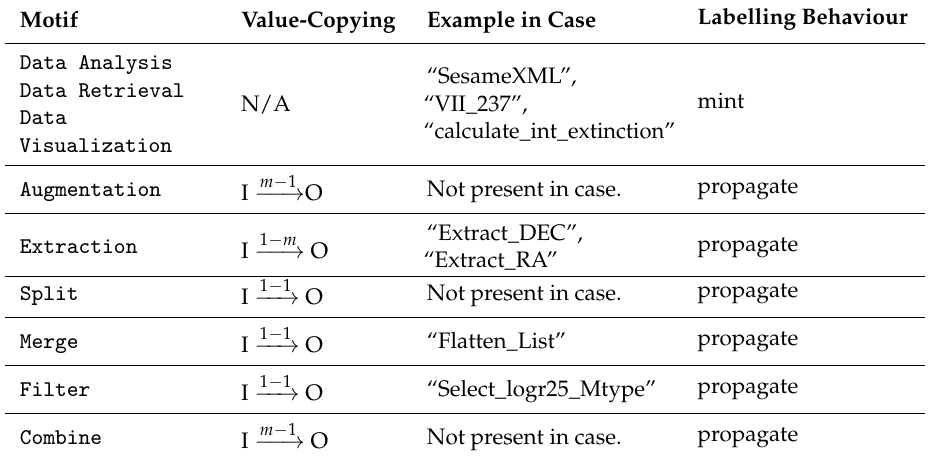
Table 3. Workflow Motifs, whether they imply value-copying, and the associated labelling